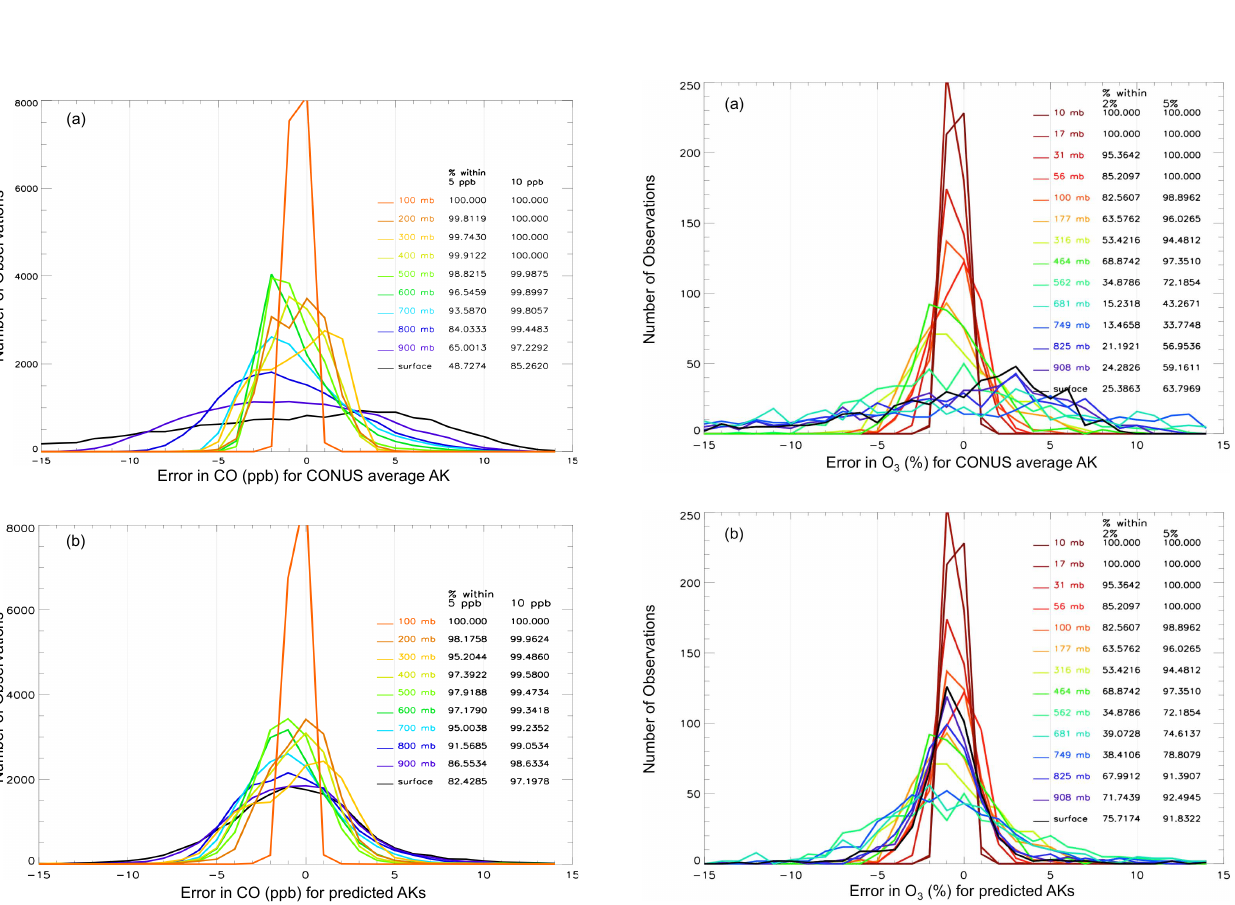
Figure 15 (a) Performance of CONUS average AK compared to true AKs for MOPITT test cases. (b) Performance of predicted AKs compared to true AKs for MOPITT test cases. Histograms of error in CO are plotted for each pressure (indicated by colors on the right). Listed on the far right, are the percentages of test cases that fall within 5 and 10 ppb CO error for each pressure. See text for description of error calculation.